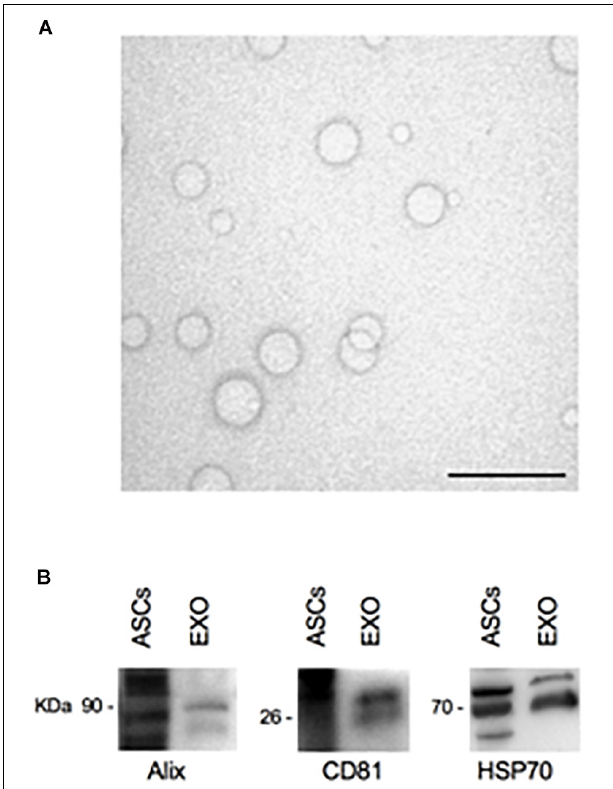
FIGURE 4 | TEM and Western blot analysis of ASCs-exosomes. (A) Electron microscopy shows vesicles with characteristic morphology and size of exosomes. Scale bar, 200 nm. (B) The blots show Western blot detection of the expression of Alix (90 kDa), CD81 (26 kDa), and HSP70 (70 kDa) in exosomes (EXO); ASCs lysates were used as positive